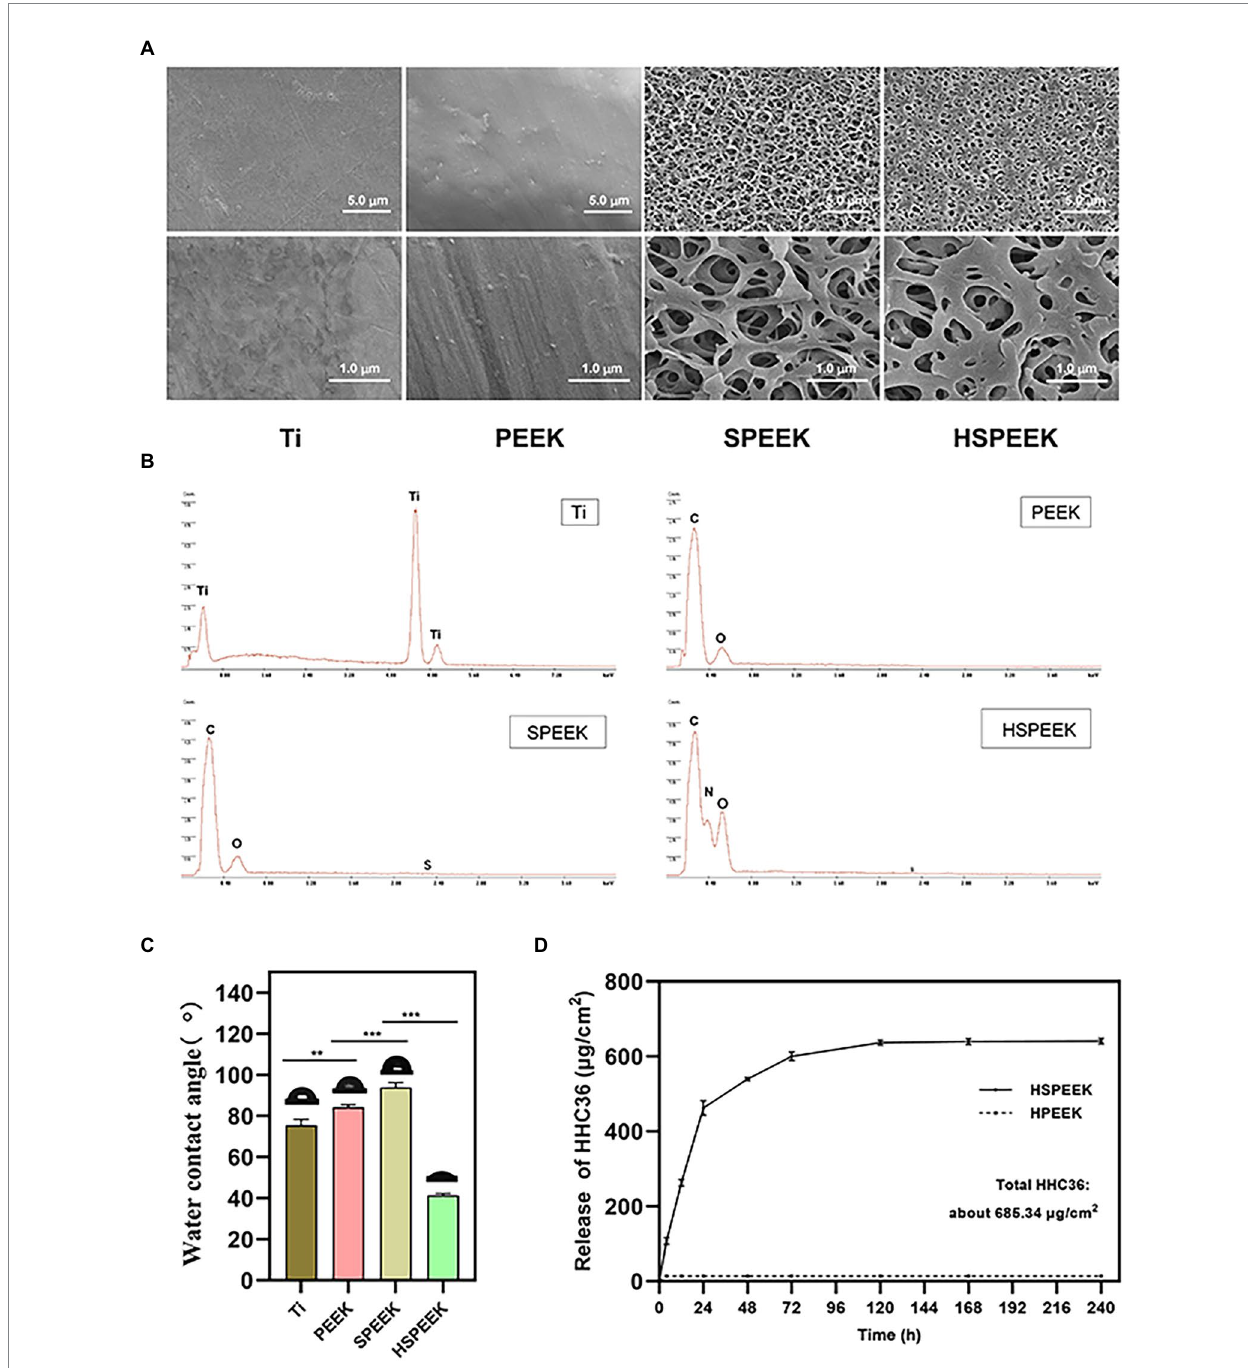
FIGURE 1 (A) FESEM morphology at low and high power of Ti, PEEK, SPEEK and HSPEEK, (B) EDS spectra of Ti, PEEK, SPEEK and HSPEEK, (C) Water contact angles of Ti, PEEK, SPEEK and HSPEEK, and (D) Release of HHC36 from HSPEEK and HPEEK in PBS. ( n = 3, ** p < 0.01, *** p <